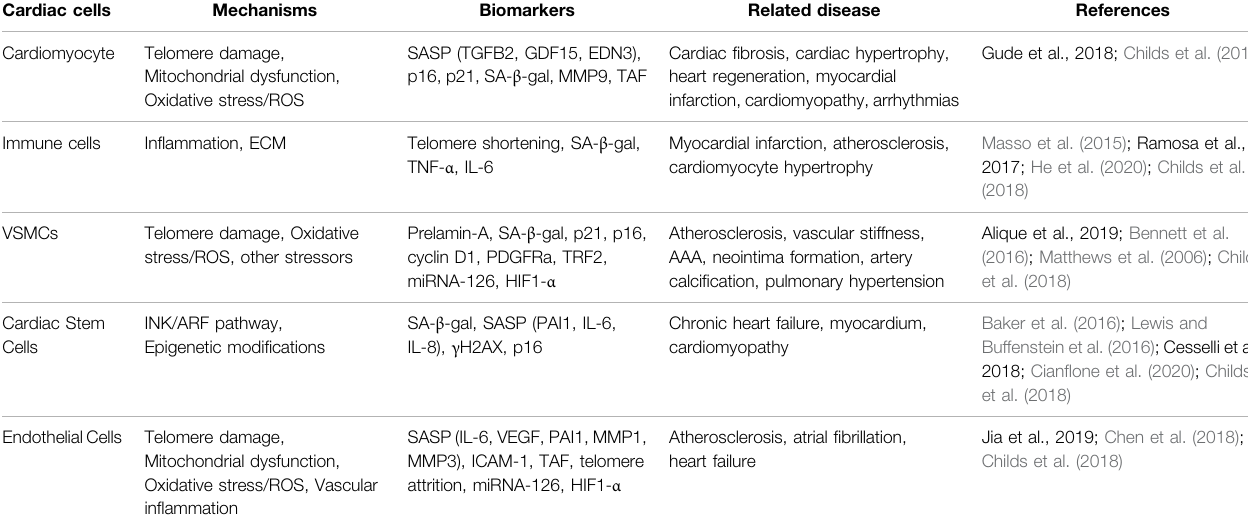
TABLE 1 | Summary of cardiovascular cell senescence pointing out the mechanisms, biomarkers and related